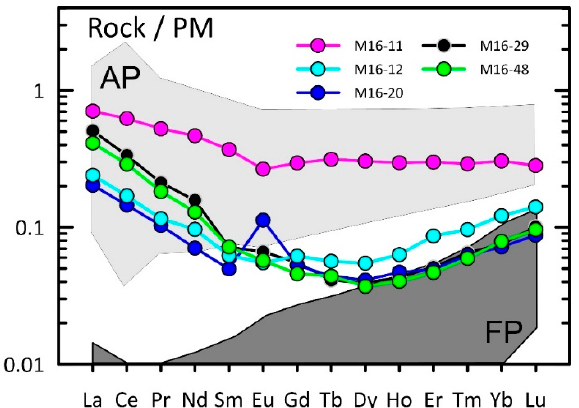
Figure 6. Primitive mantle-normalized [52] rare-earth-element patterns in the bulk-rock Alag Khadny peridotites. The background data are provided for forearc peridotites (FP) [41] and abyssal peridotites (AP) [51].